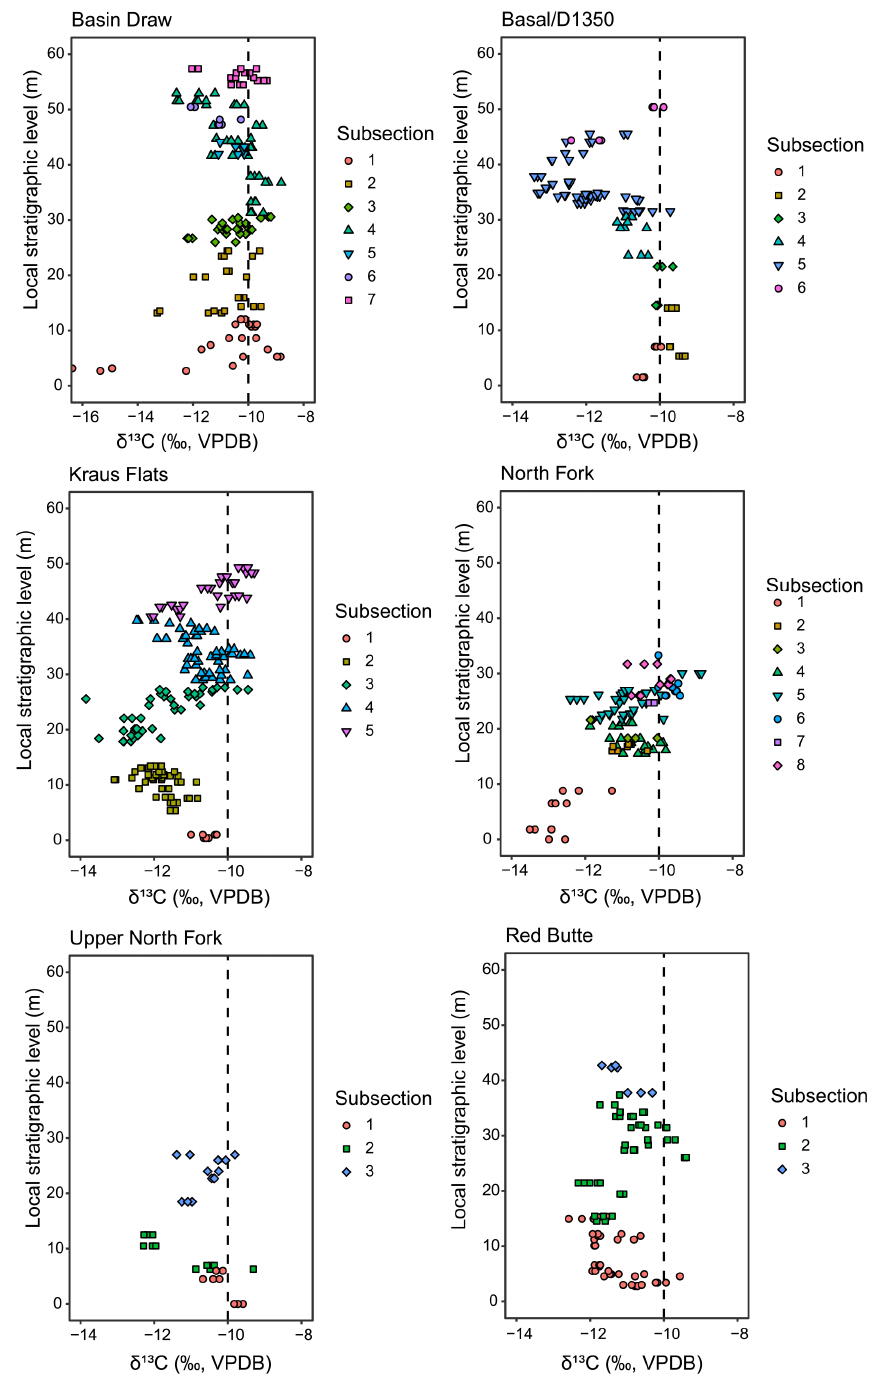
Figure A10. Carbon isotope stratigraphy for each section with symbols showing different subsections. Points represent individual sample measurements. The black dashed line at − 10‰ shows the typical background value for Fifteenmile